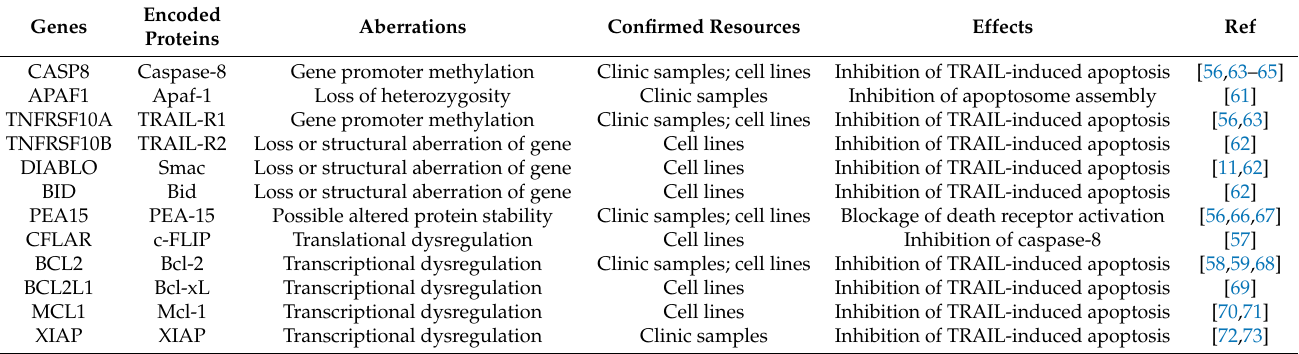
Table 1. Aberrations in TNF-related apoptosis-inducing ligand (TRAIL)-induced apoptotic signaling in GBM.